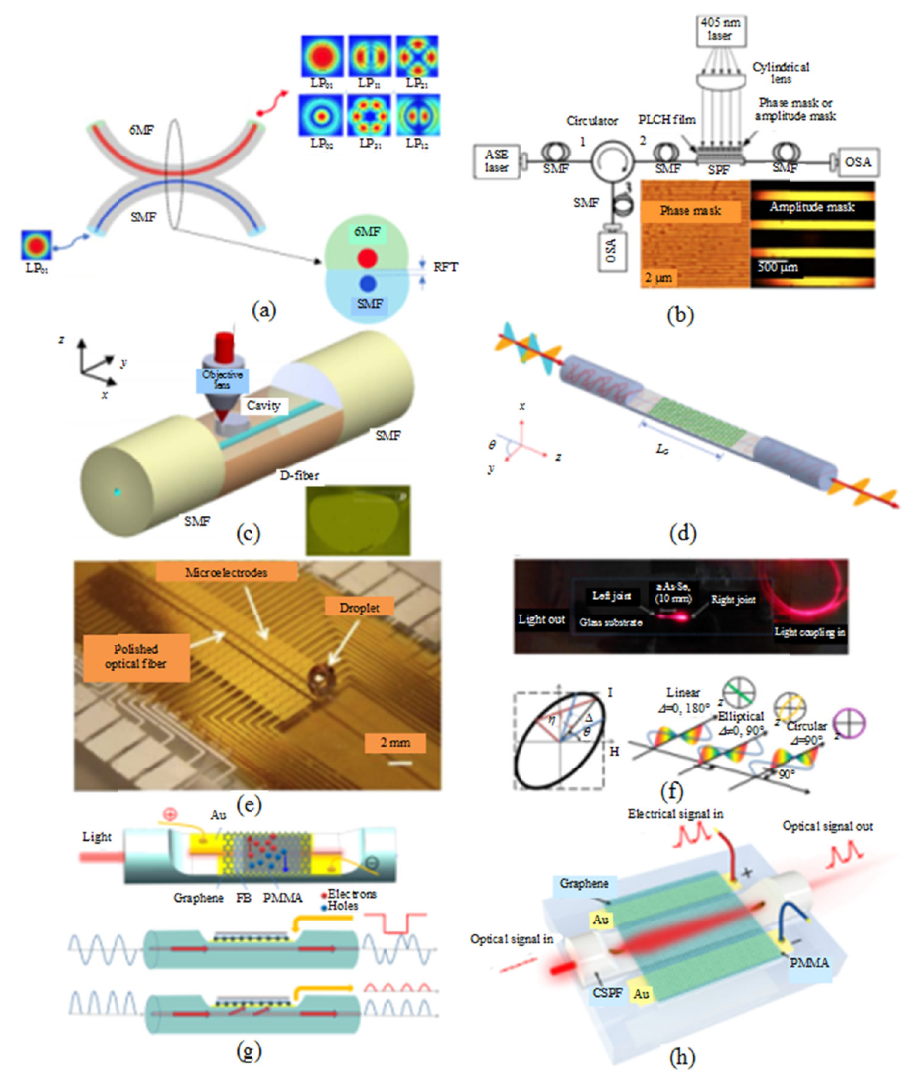
Fig. 3 SPF- -based optical experimental s (c) schematic d (e) schematic d to SOP and the modulator and photodetector